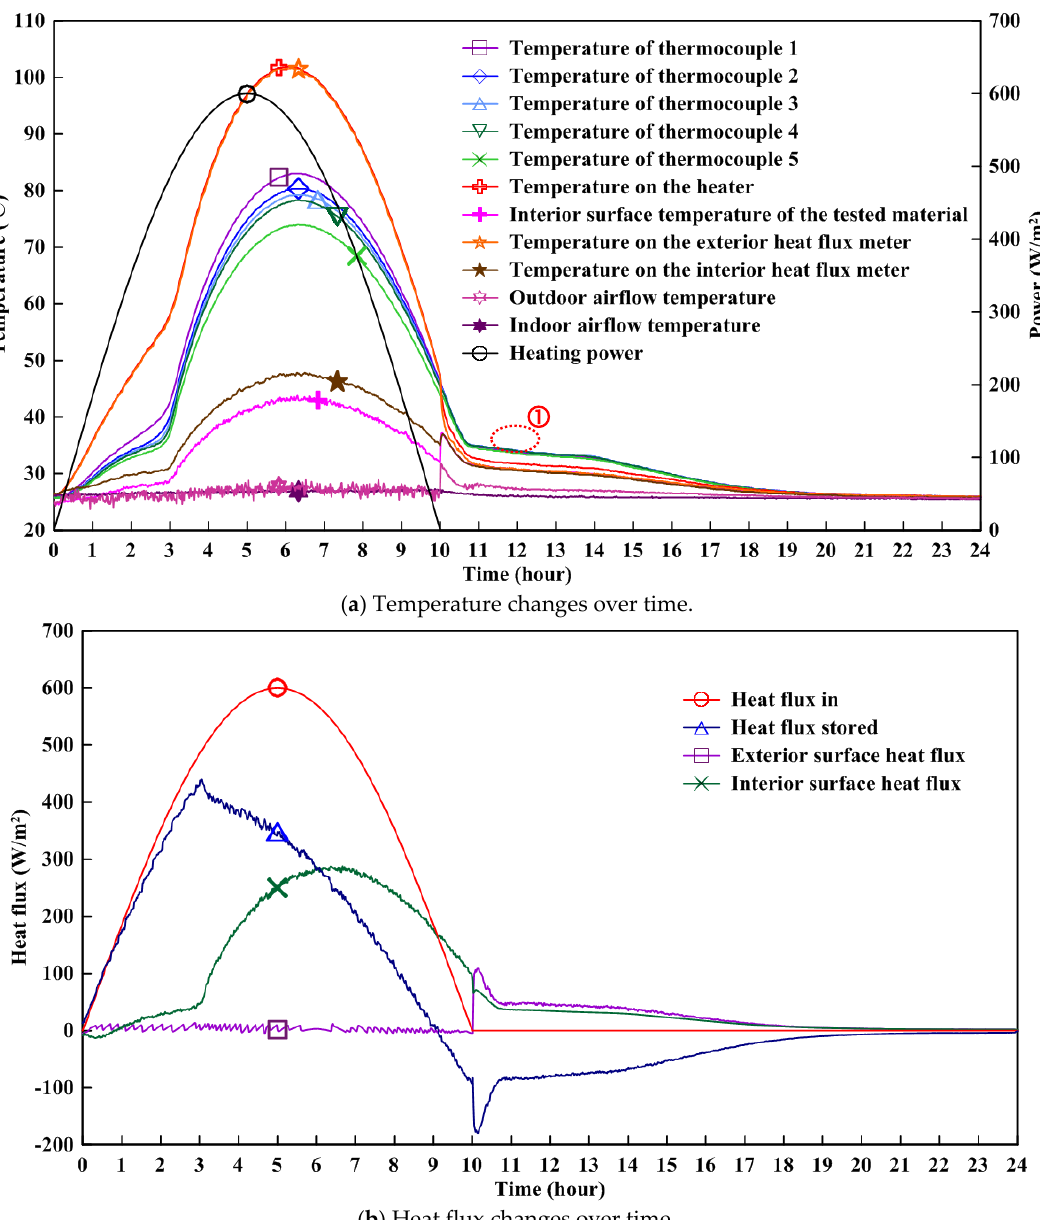
Figure 4. Heat transfer behavior of the tested module (Tm = 37 °C, Gs,o = 600 W/m 2 ).